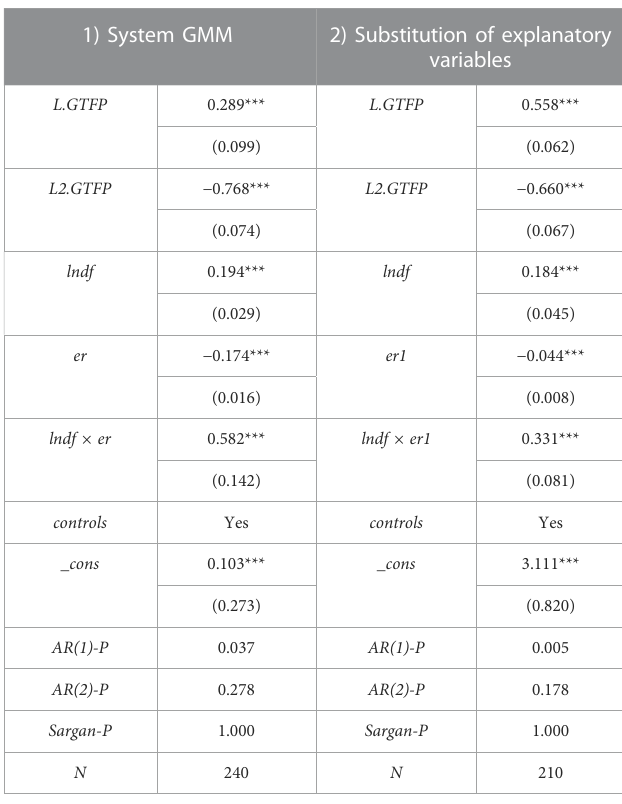
TABLE 5 Robustness